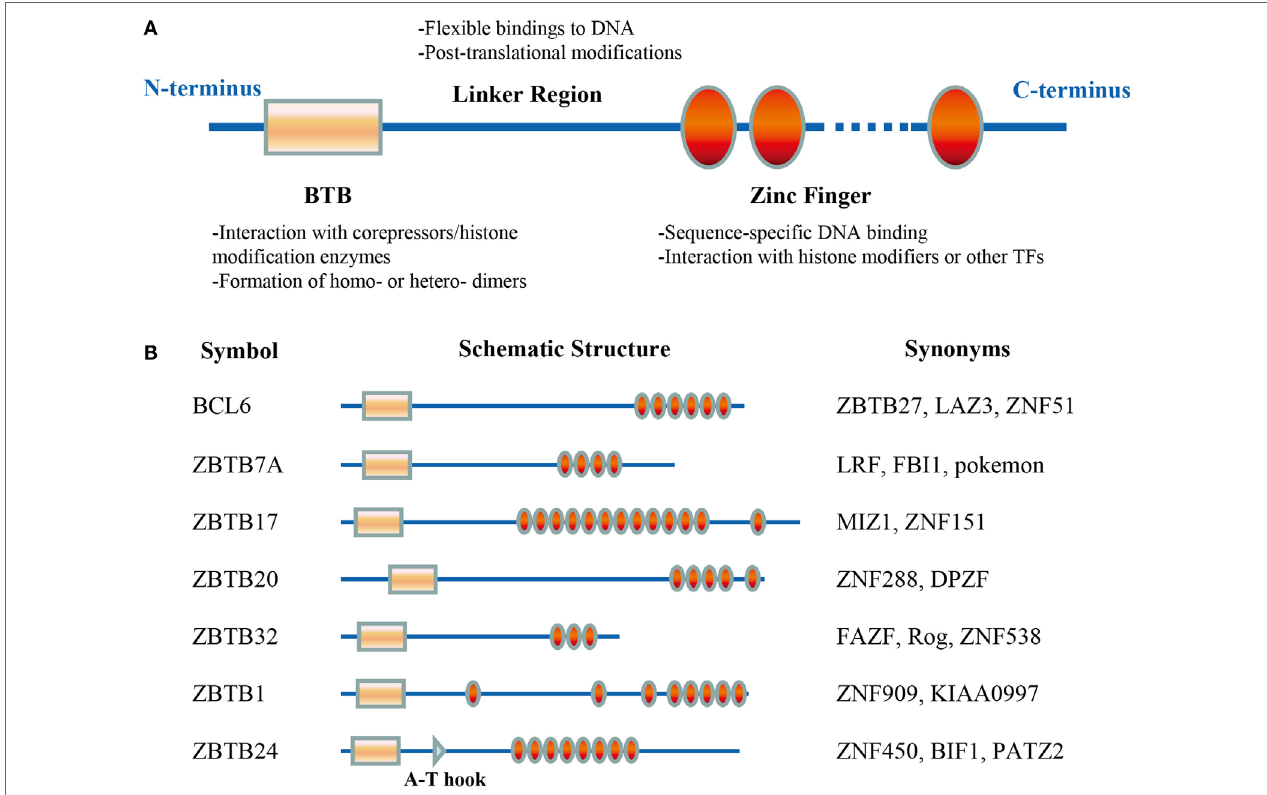
FigURe 1 | Schematic illustrations of the structure and function of ZBTB protein domains. The BTB domain, located at the N-terminus, mediates the protein– protein interactions. The C-terminal zinc fingers (ZFs) mainly mediate the binding to DNA, but they may interact with histone modifiers or other transcriptional factors (TFs) as well. The linker domain is unstructured and often targeted for posttranslational modifications (A) . (B) Functional domains of the seven ZBTB proteins discussed in this review. ZBTB24 contains an additional A-T hook